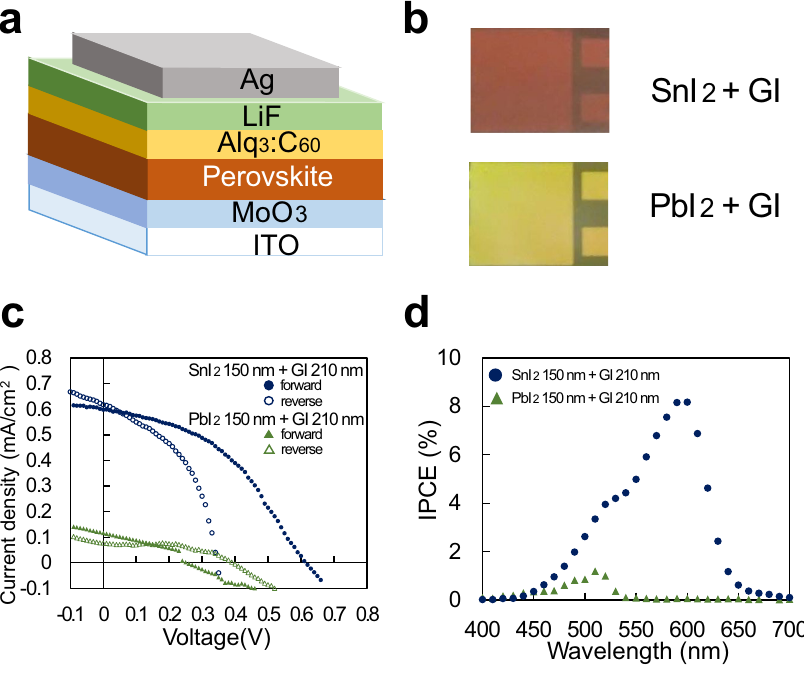
Figure 2. Solar cells fabricated by two-step method of vacuum evaporation using SnI 2 or PbI 2 as a metal halide and GI as an amine halide. ( a ) Device structure, ( b ) picture of the films, ( c ) J - V curve, and ( d )